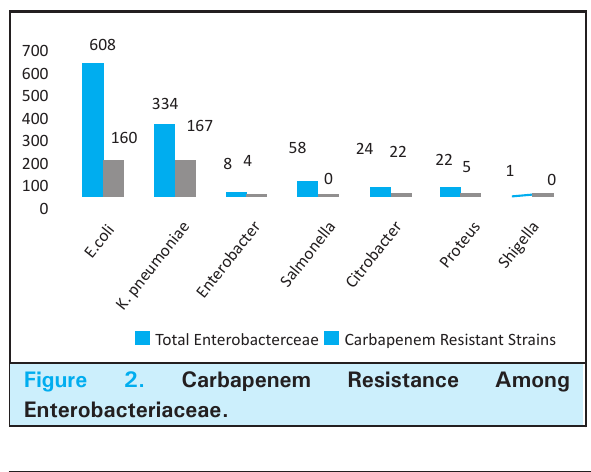
Table 1. Comparison of Carbapenem Resistance in E.coli and K.pnuemoniae.